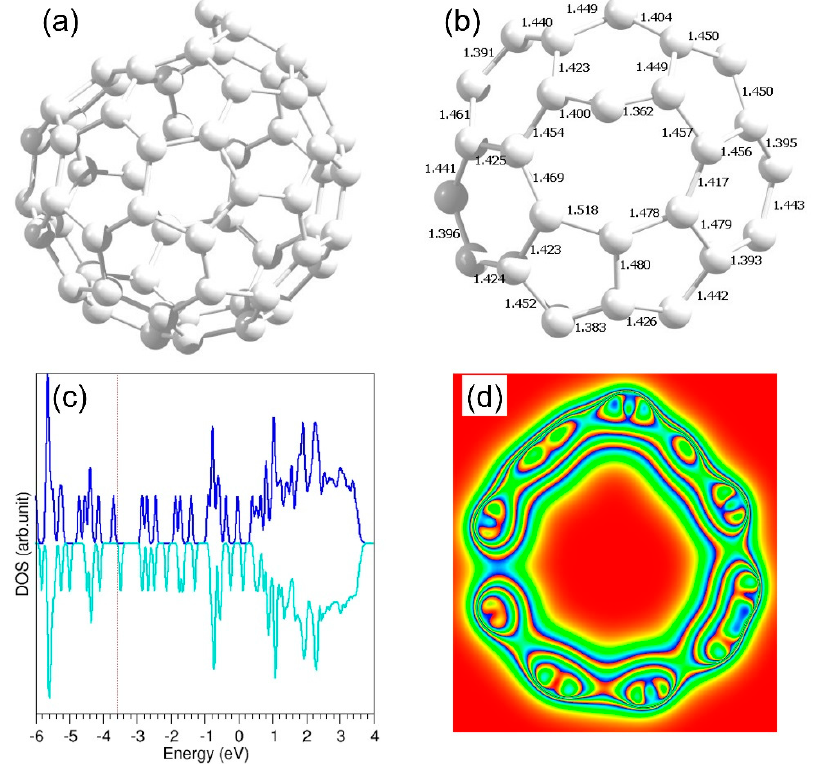
Figure 7. ( a ) Relaxed structure of a defective C 60 molecule ( b ) bond distances around the defect ( c ) DOS and ( d ) cross sectional charge density plot.